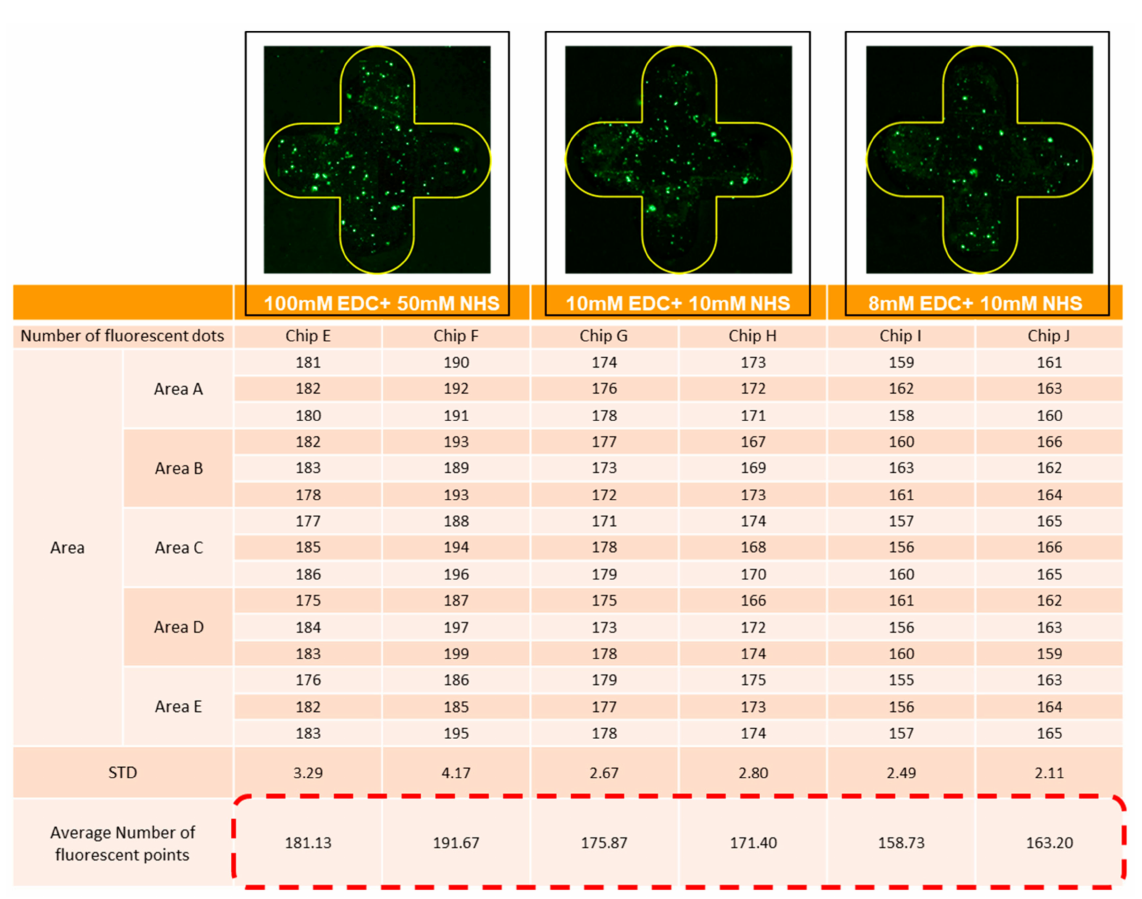
Figure 6. Experimental results and fluorescence quantity of three EDC/NHS